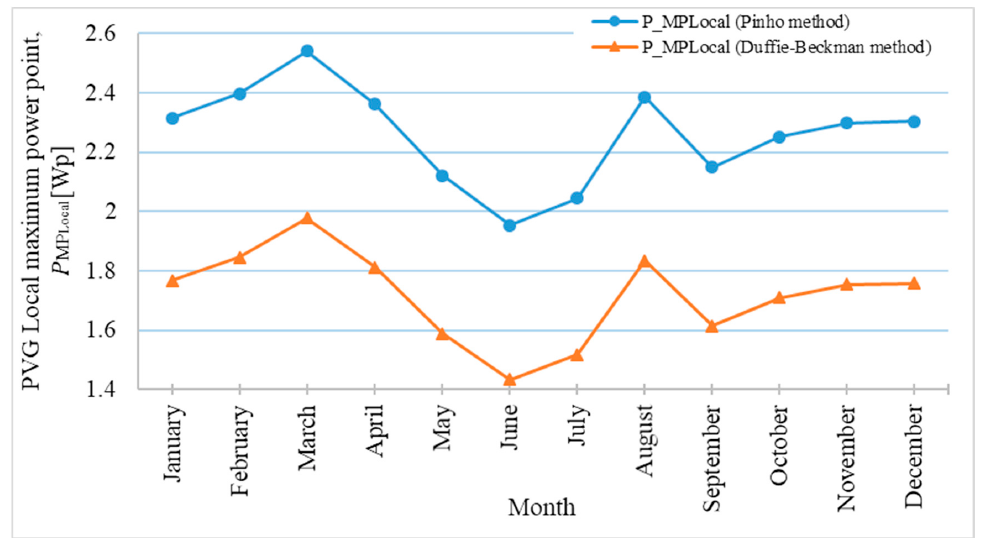
Figure 6. Monthly PVG electric power generated at the maximum power point.